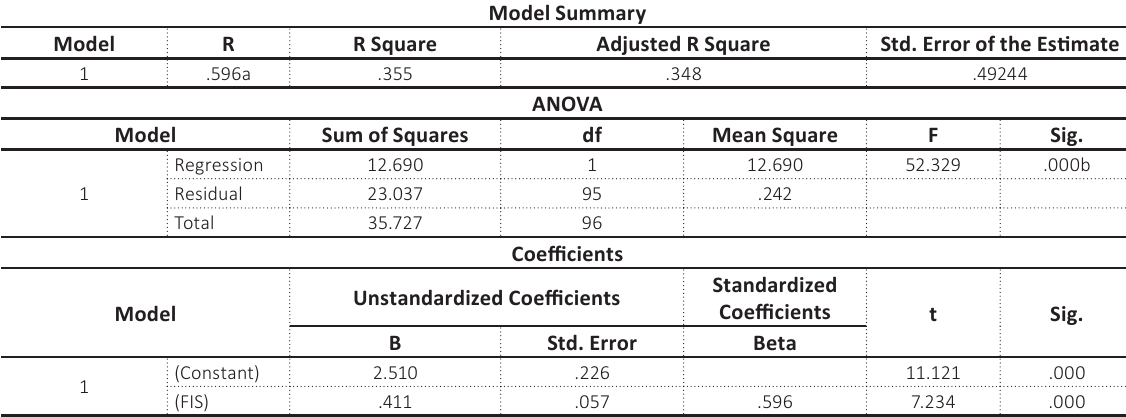
Table 4 Main hypothesis testing